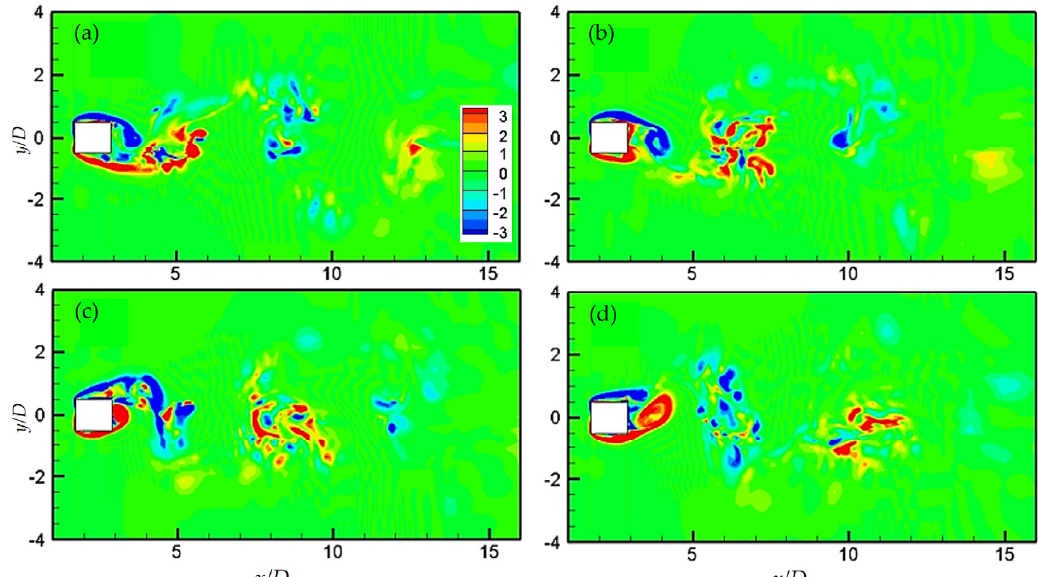
Figure 14. Instantaneous contours of the spanwise vorticity ω z for α = 30 ◦ on the ( x , y ) plane at z = 4 D within one vortex shedding period T. ( a ) t = 0; ( b ) t = T/4; ( c ) t = 2T/4; ( d ) t = 3T/4.